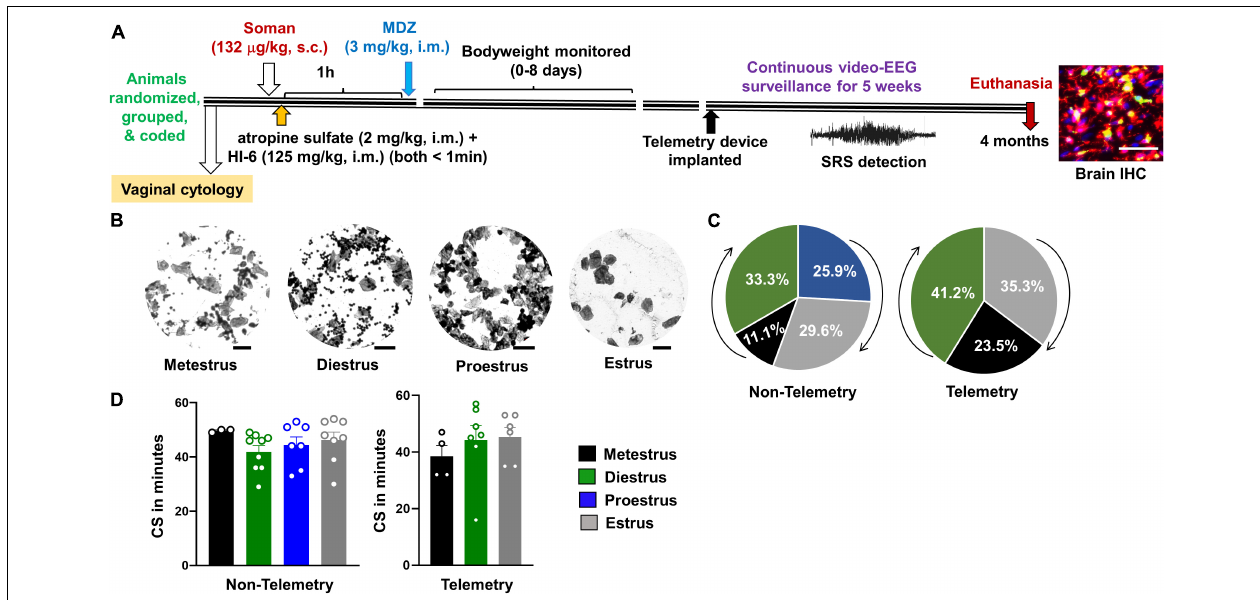
FIGURE 1 | Experimental design and the relationship between estrous and convulsive seizures (CS) duration during status epilepticus (SE). (A) After randomization, grouping, and coding, three cohorts of animals were exposed to soman; first cohort had 24 rats (all males; nine rats from this group were used for implanting telemetry device at ∼ 3 months post-soman), second cohort had 50 rats without telemetry (25 rats per sex), and the third cohort had 35 rats with telemetry (17–18 rats per sex) and 10 rats without telemetry (eight males and two females). Each cohort of animals received soman (132 µ g/kg, s.c.), HI-6 (125 mg/kg, i.m.), atropine sulfate (2 mg/kg, i.m.), and midazolam (3 mg/kg, i.m.) from the same pool of reagents prepared fresh on the day of the experiment. (B) Representative images showing vaginal cytology at each stage of estrous. Scale = 25 µ m. (C) Percent of telemetry and non-telemetry animals at each stage of estrous. (D) Number of minutes in CS during SE for females in each stage of estrous. ANOVA or Kruskal–Wallis ( n =